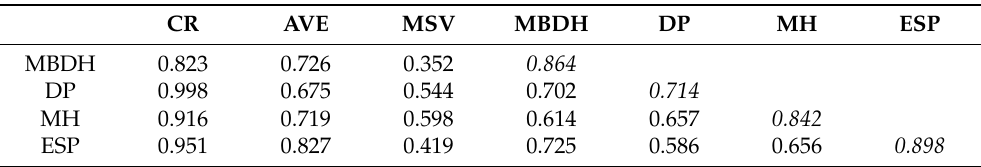
Table 5. Convergent and discriminant